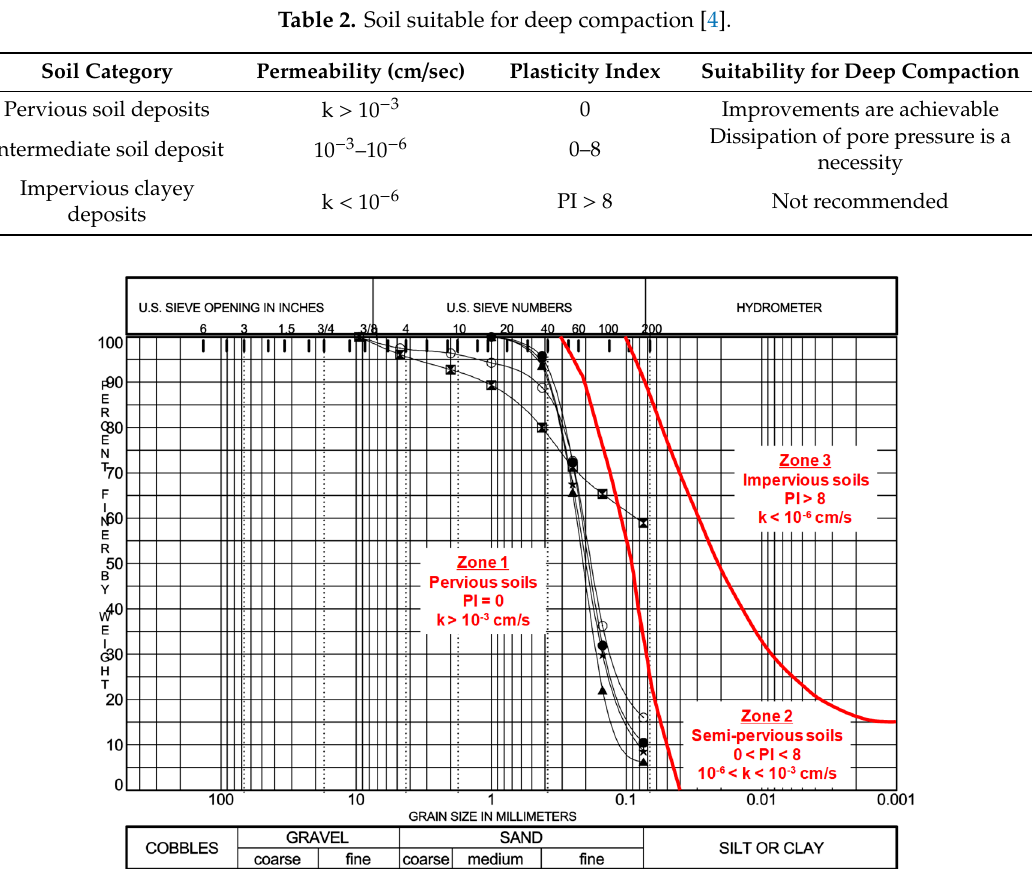
Figure 3. Range of soil gradation of deposits suitable for deep compaction [4].